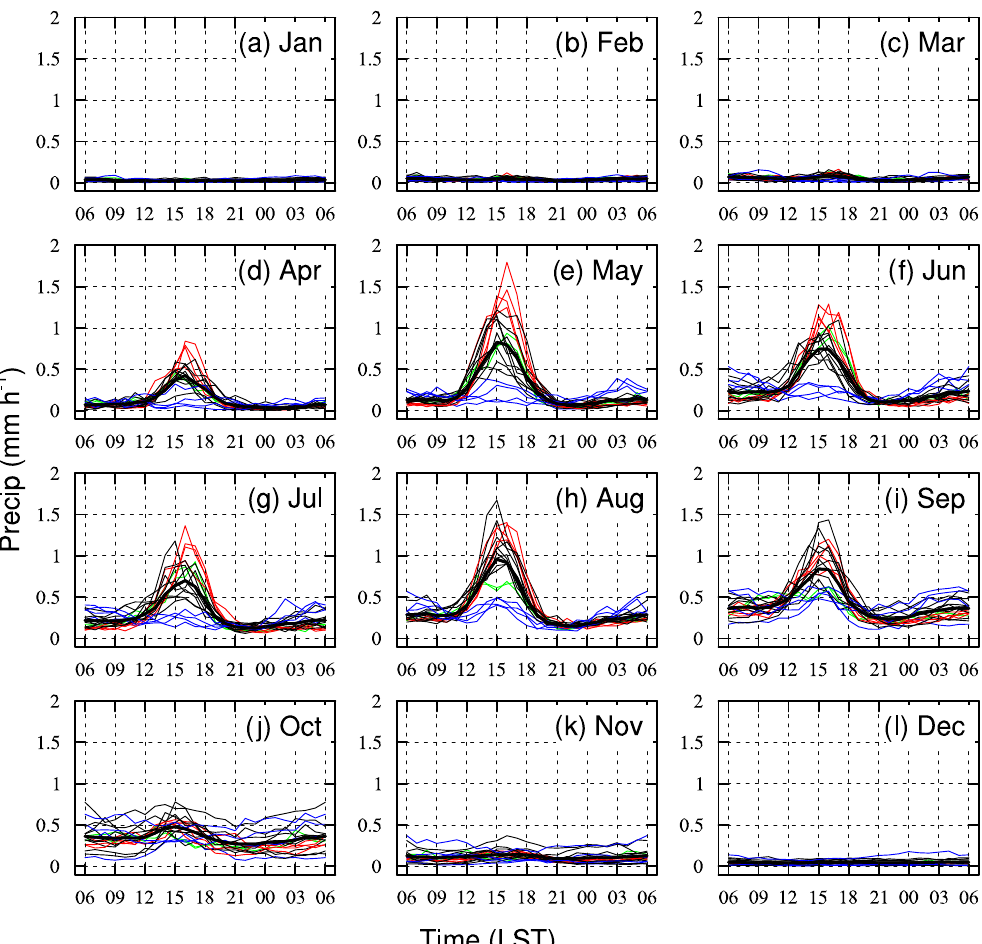
Figure 2. Average rainfall accumulations by hour for each month of the year, obtained from the rain gauge network. The color is consistent with the colored dots over the island in Fig. 1. LST means local standard